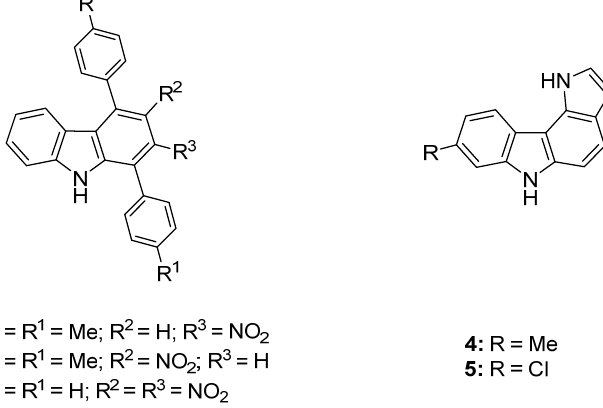
Figure 1. Molecular structures of compounds 1 – 8.